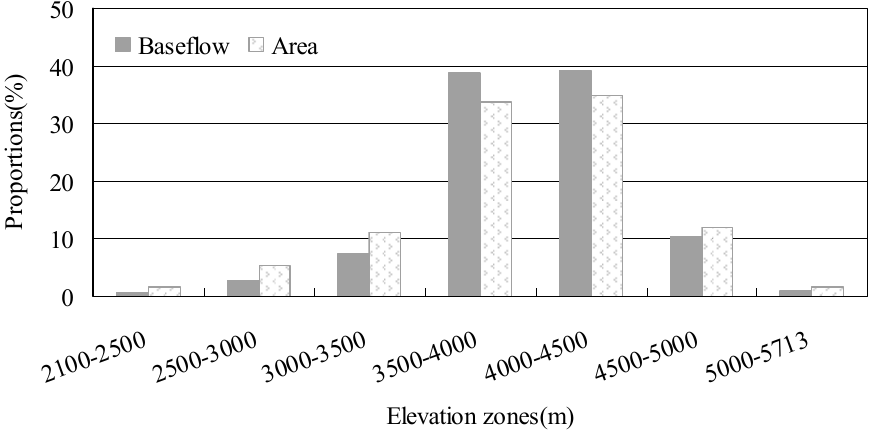
Figure 8. Proportions of the watershed area and baseflow at different elevations of the study area.